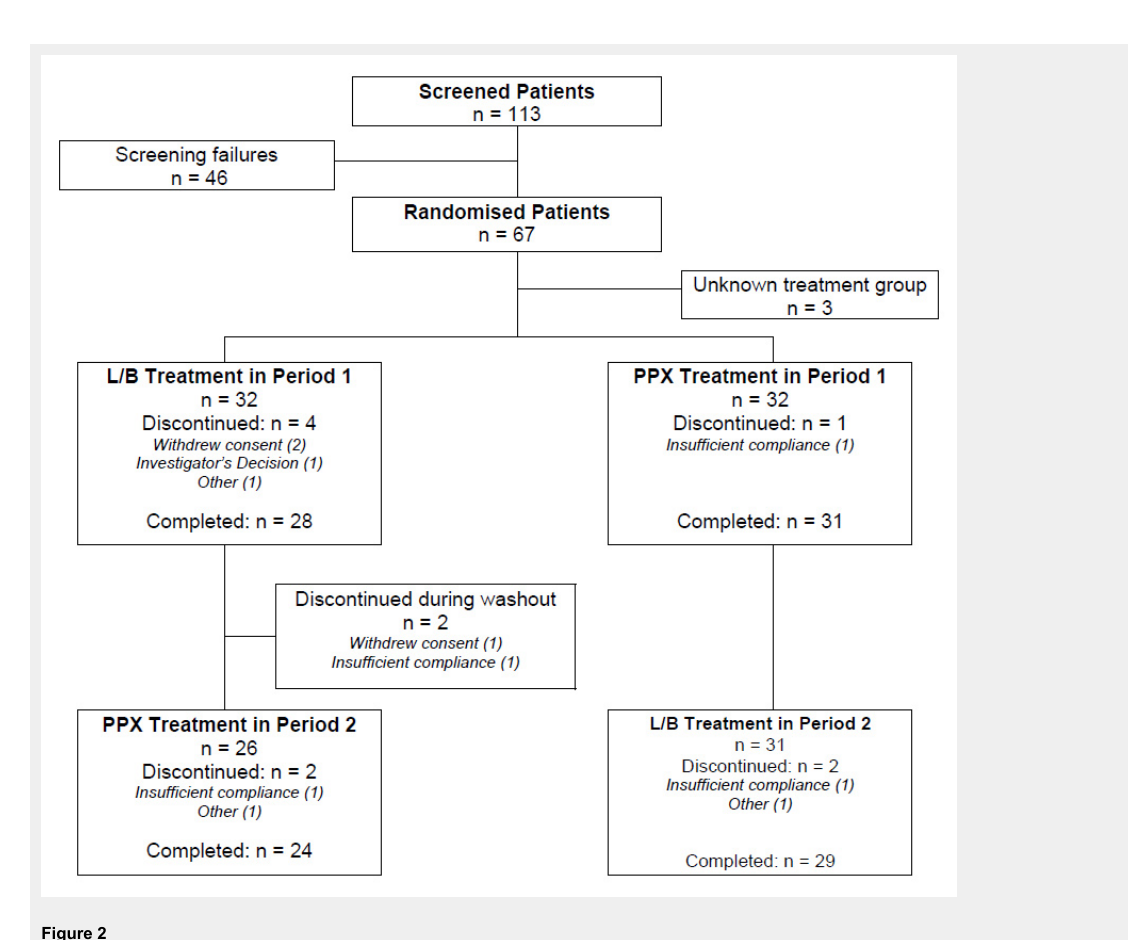
Figure 2 Patient